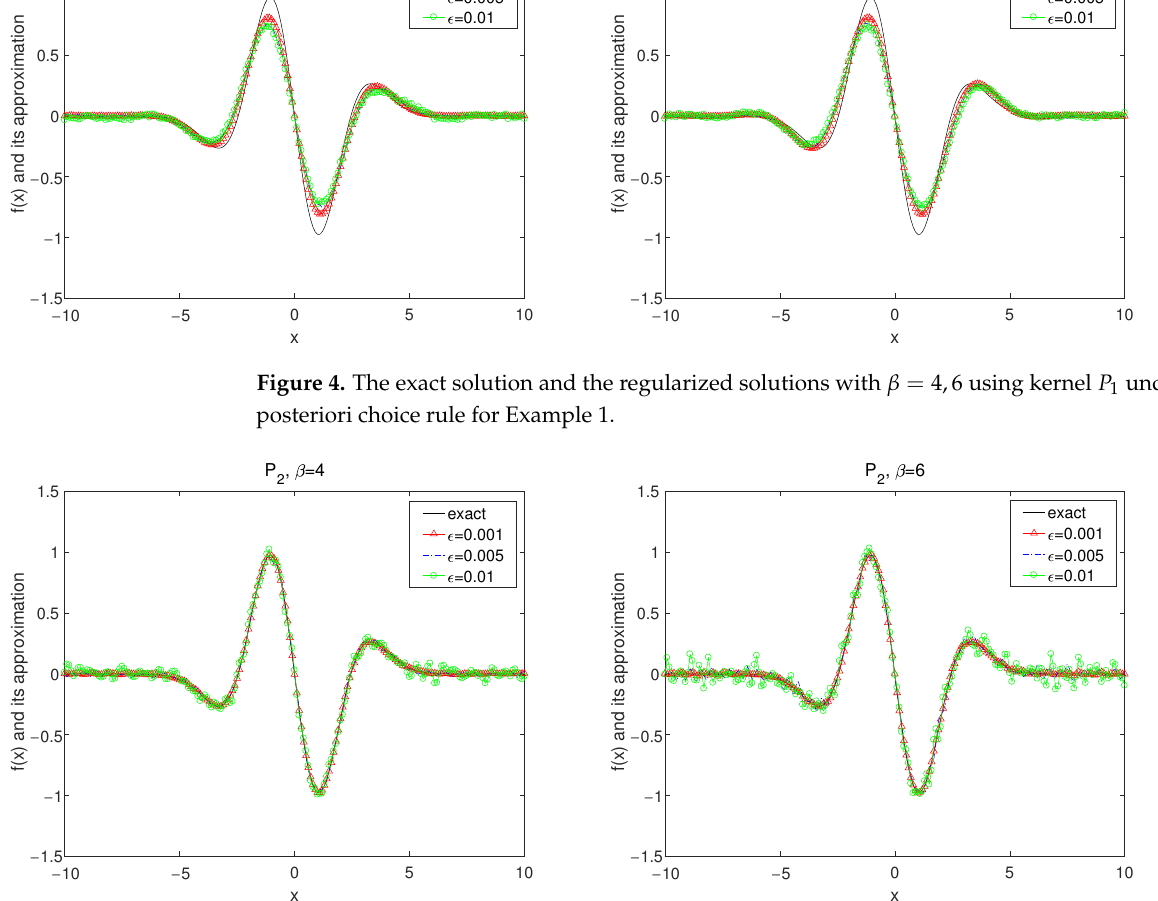
Figure 5. The exact solution and the regularized solutions with β = 4,6 using kernel P 2 under the a posteriori choice rule for Example